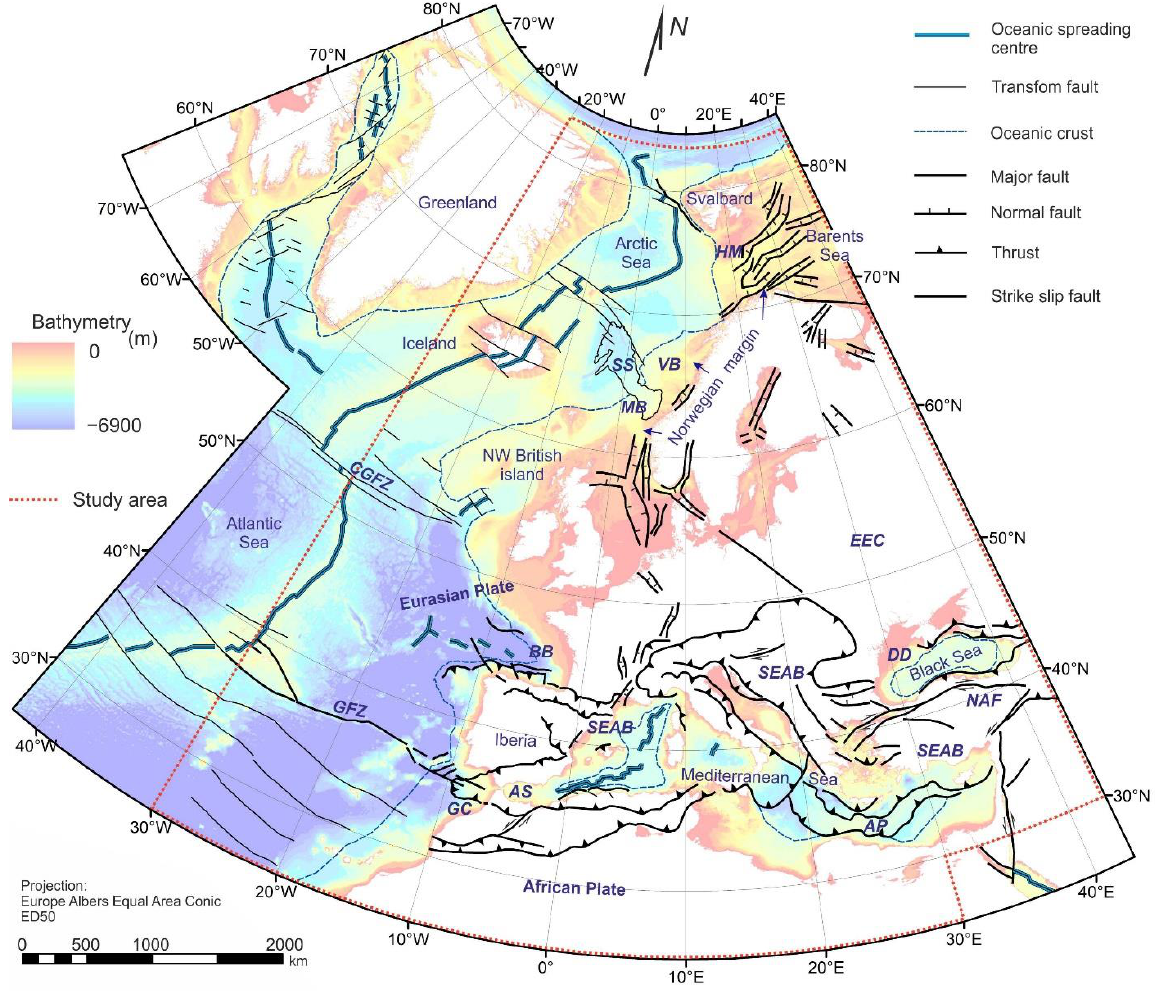
Figure 1. Main tectonic structures and geological domains on the European continental margins and adjacent areas. Location of the study area. HM, Håkon – Mosby mud volcano; VB, Vøring Basin; MB, Møre Basin; SS, Storegga Slide; CGFZ, Charlie – Gibbs fracture zone; EEC, East European craton; Biscay Bay; GFZ, Gloria Fracture Zone; GC, Gulf of Cádiz; AS, Alborán Sea; SAEB, south European Alpine Belt, NAF, North Anatolian Fault; DD, Danube delta fan. (Taken from [23,33,34]).